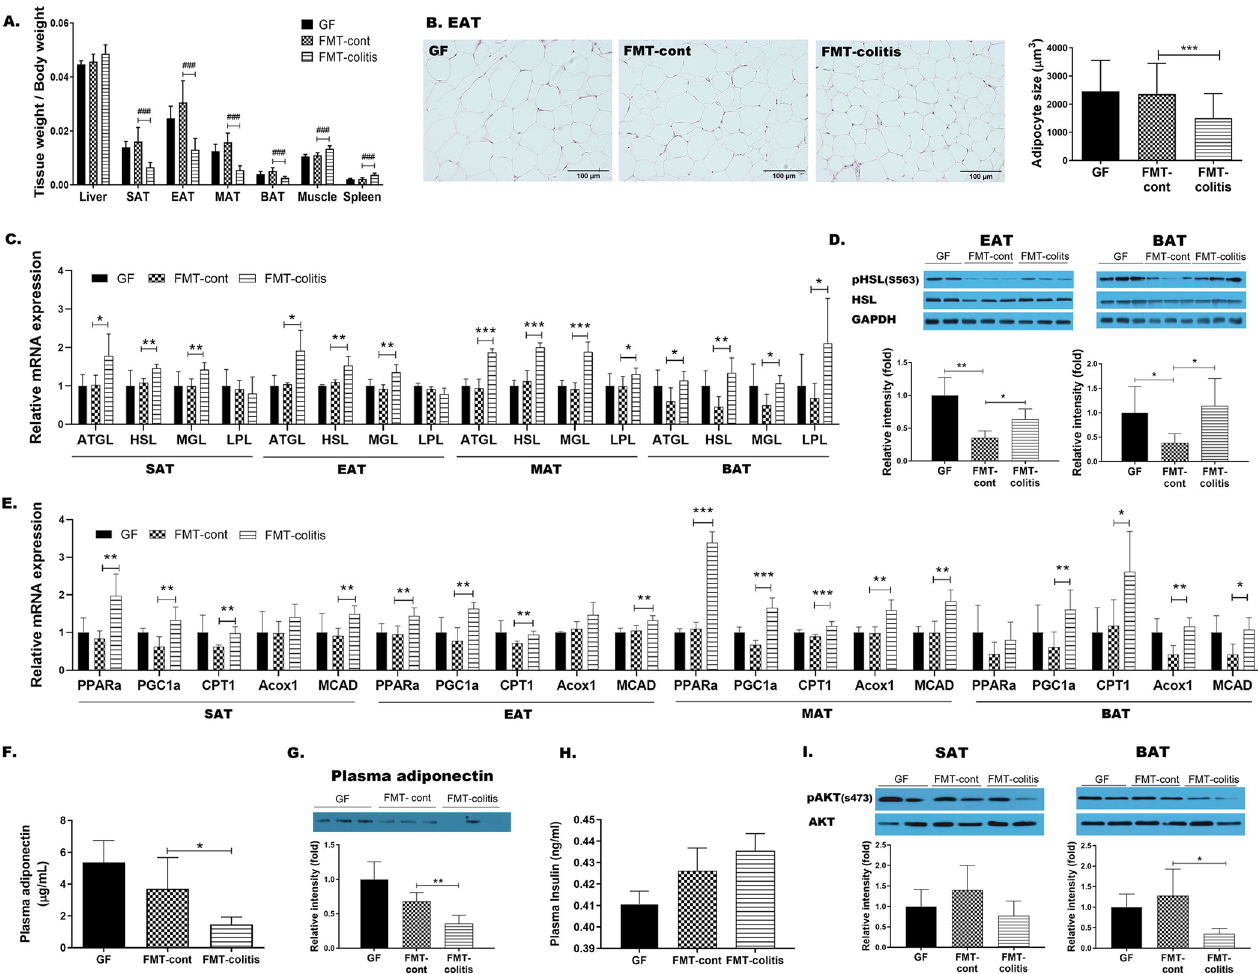
Fig 2. Transplantation of fecal microbiota from colitis mice reduced the weight of adipose tissue and caused its dysfunctions in GF recipient mice. (A) The ratio of tissue weight/body weight. In A, statistical significance was determined by ordinary one-way ANOVA with Dunnett’s multiple comparison test ( # p < 0.033, ## p < 0.002, and ### p < 0.001). (B) Representative images (x200) of H&E stained adipose tissue sections and a graph presenting the size of adipocytes in EAT. (C) The gene expressions related lipolysis in MAT, EAT, SAT and BAT. (D) HSL phosphorylation (ser563) in EAT and BAT detected by SDS-PAGE-immunoblotting. (E) The gene expressions related fatty acid oxidation in MAT, EAT, SAT and BAT. Plasma adiponectin levels measured by (F) ELISA and (G) SDS-PAGE-immunoblotting. (H) Plasma insulin levels measured by ELISA. (I) Akt phosphorylation (ser473) in SAT and BAT detected by SDS-PAGE-immunoblotting. Data are presented as mean ± SD of each group (n = 5–7). In B-J, Student’s two-tailed t-test was used for analysis difference between FMT-control and FMT-colitis group ( � p < 0.05, �� p < 0.01, and ��� p < 0.001).